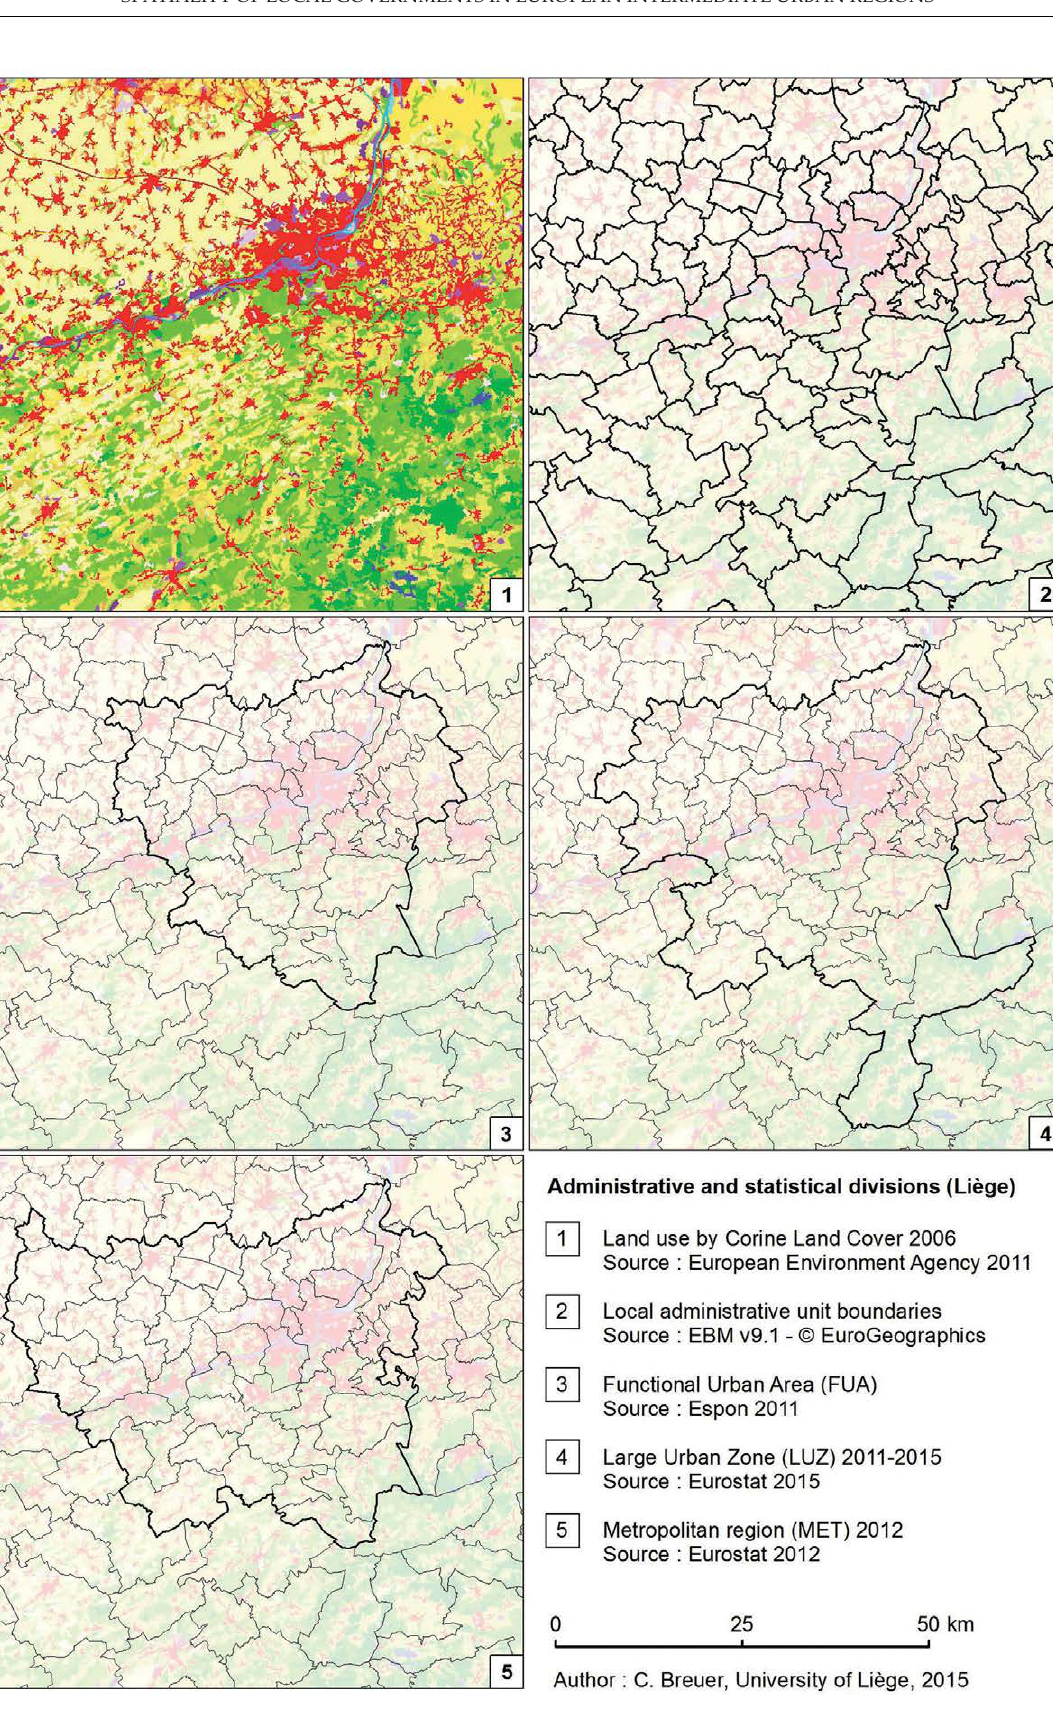
Fig. 2. Urban statistical divisions in Liège,